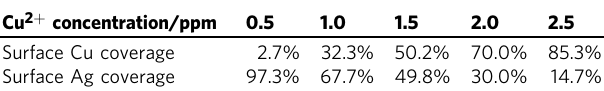
Table 1 Surface Cu coverage with different Cu 2 + concentrations in the electrolyte Cu 2 + concentration/ppm